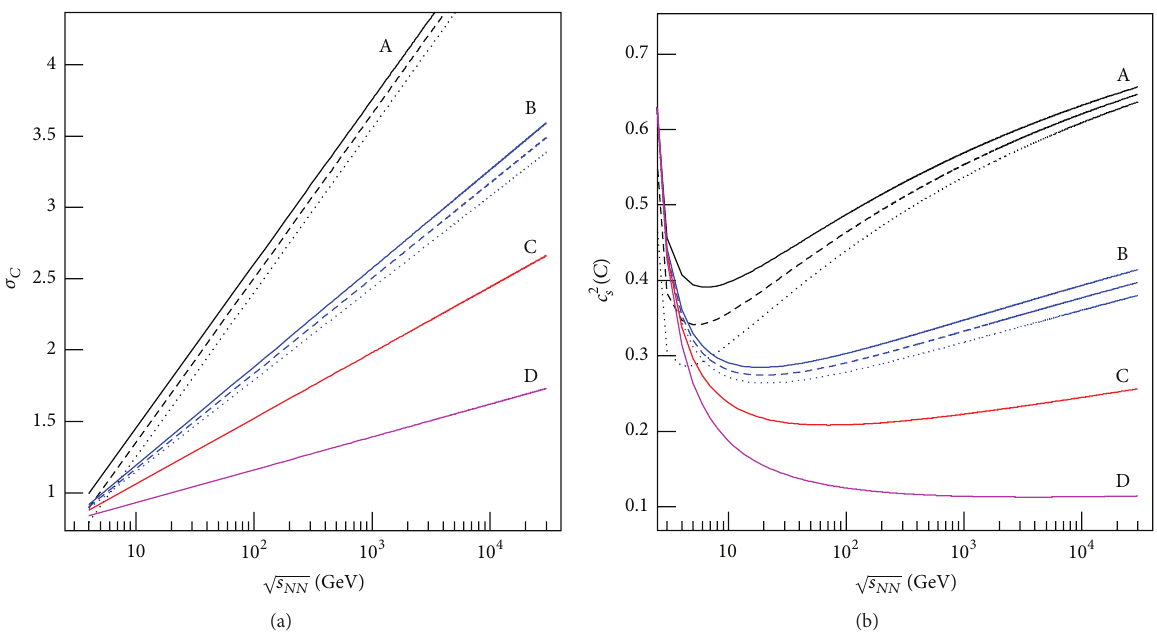
Figure 5: (a) A few examples of linear relations between 𝜎 𝐶 and ln √𝑠 𝑁𝑁 . (b) Different linear relations between 𝜎 𝐶 and ln √𝑠 𝑁𝑁 corresponding to different dependences of 𝑐 2 𝑠 (𝐶) on √𝑠 𝑁𝑁